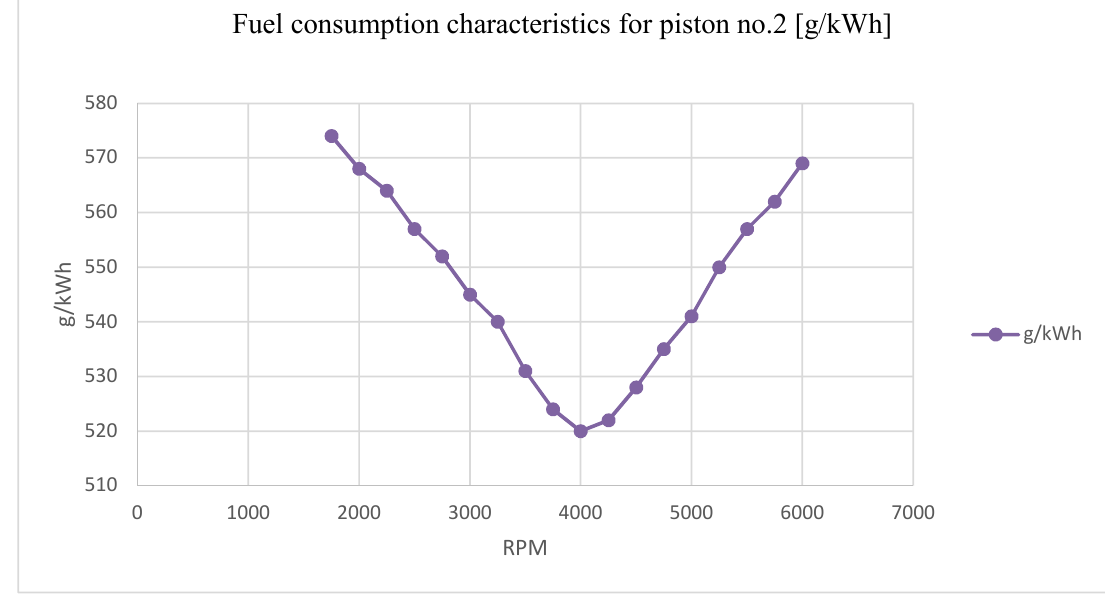
Figure 22. Fuel consumption characteristics for piston no. 2.